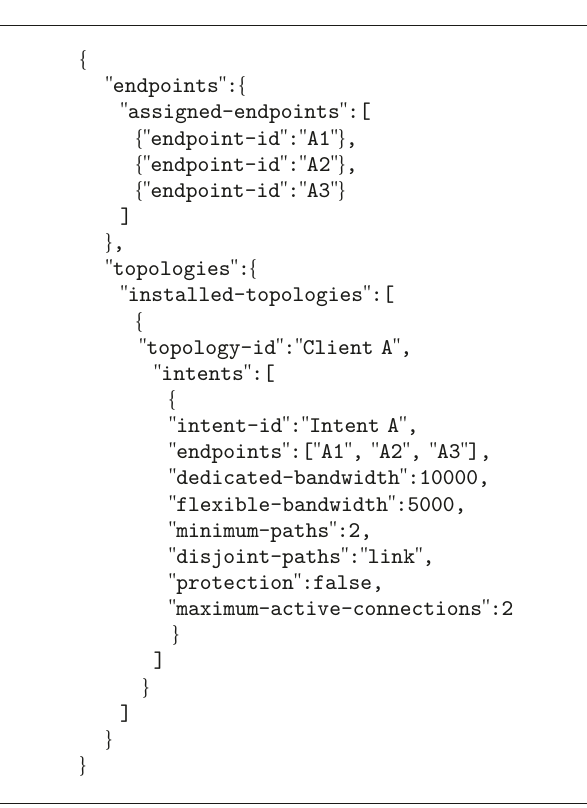
figuration management using NETCONF and YANG,”